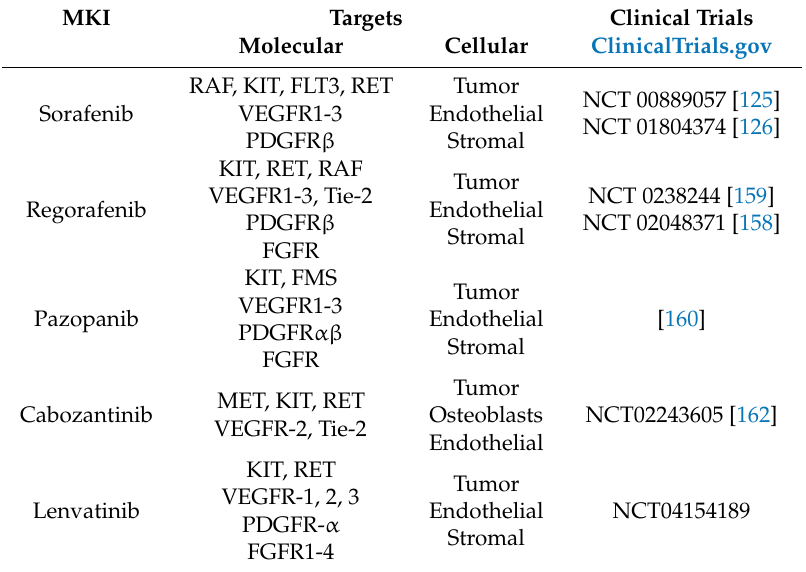
Table 1. Multi-kinases inhibitors (MKI) in Osteosarcoma (OS): Molecular and Cellular Targets and Clinical